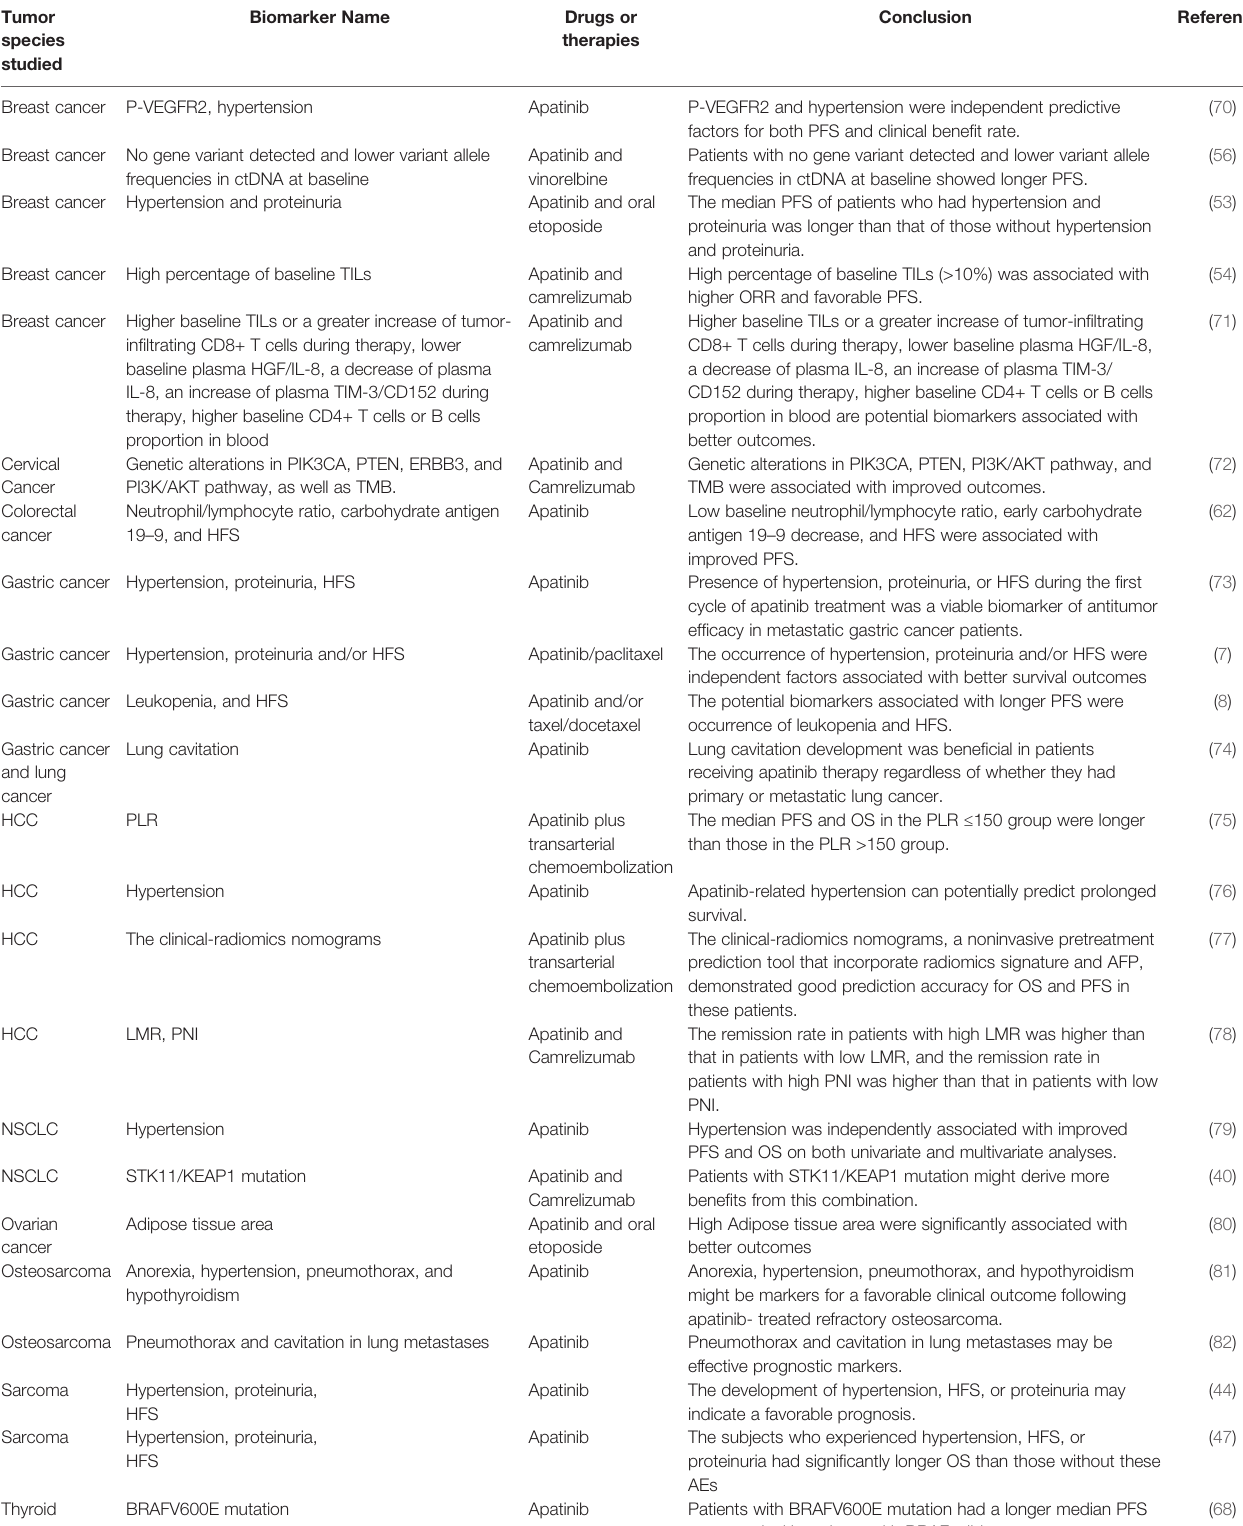
TABLE 7 | Response biomarkers of apatinib associated with improved outcomes in the treatment of